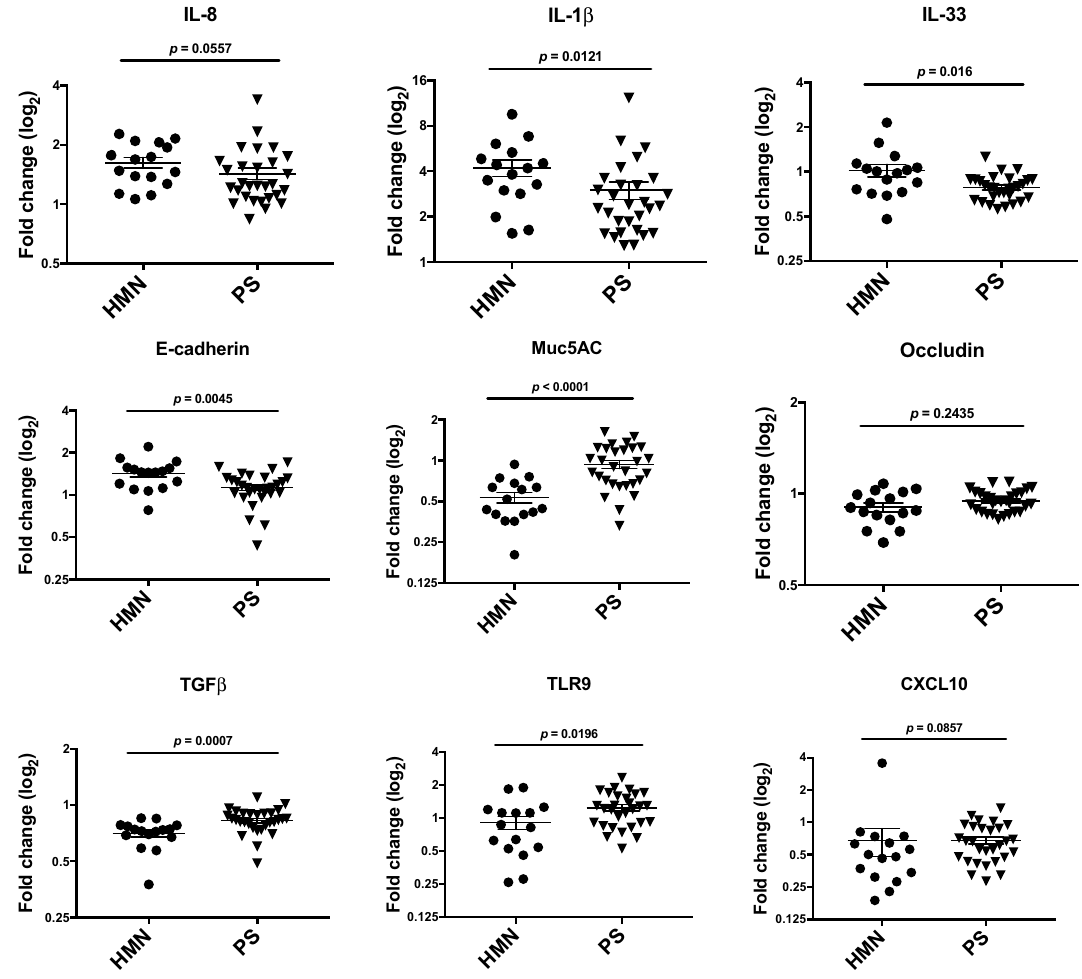
Figure 3. Comparative analysis of epithelial gene expression induced following exposure of cultured epithelial cells to sterile products of Haemophilus - Moraxella - Neisseria ( HMN ) or Prevotella - Streptococcus ( PS )